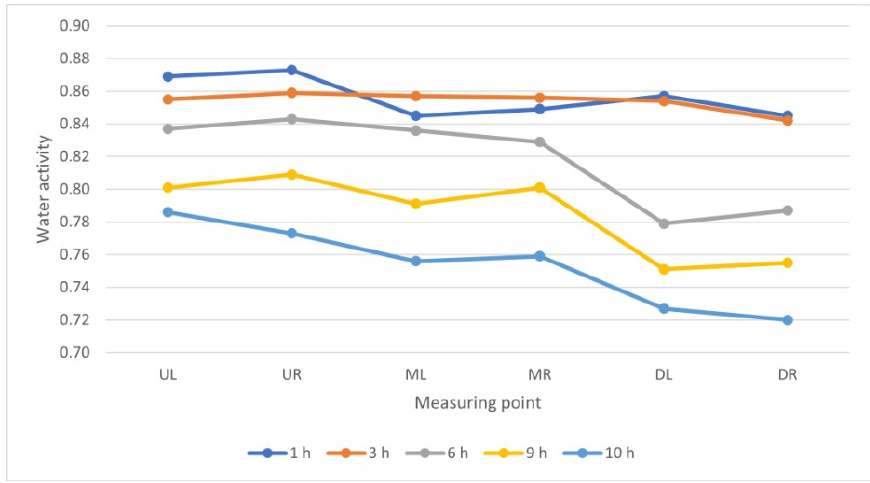
Figure 17. Comparison of changes of Wa (water activity) in dried beef in chamber 1, taken from